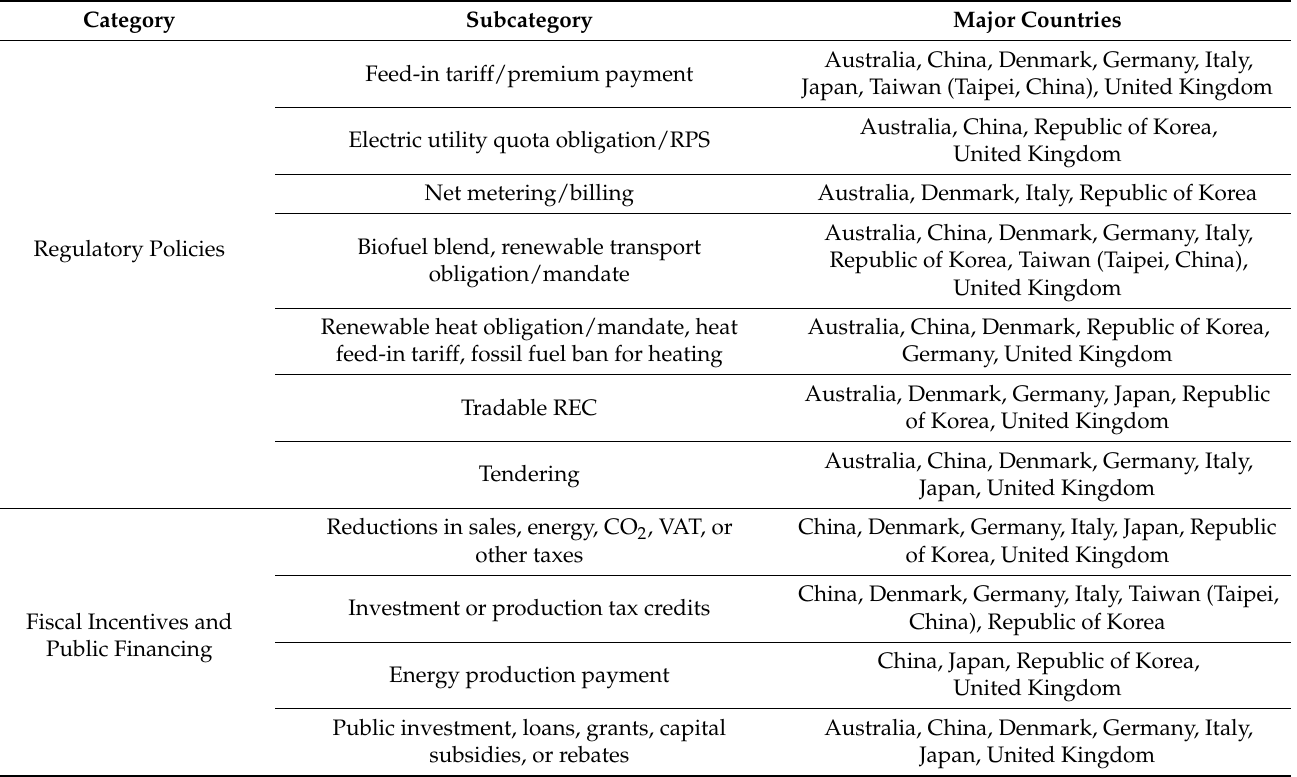
Table 2. Policies on renewable